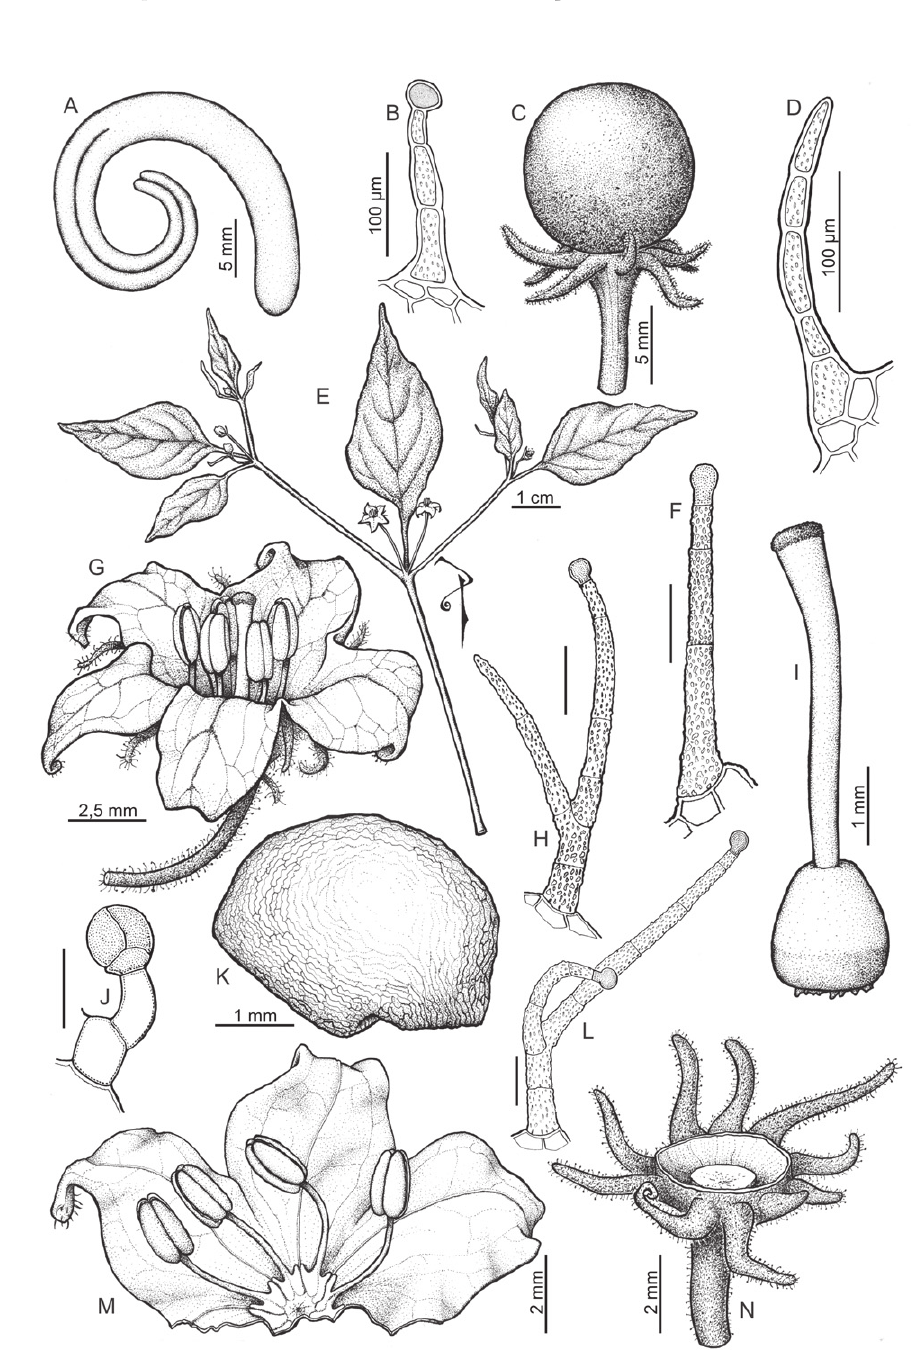
Figure 2. Capsicum eshbaughii . A embryo B, H, F, J, L glandular trichomes C fruit D non-glandular trichome E fl owering branch G fl ower I gynoecium K seed M open corolla N fruiting calyx. Line drawing by P. Peralta; voucher A, C, K, N Nee 36164; B, D-J, L, M Eshbaugh 1943